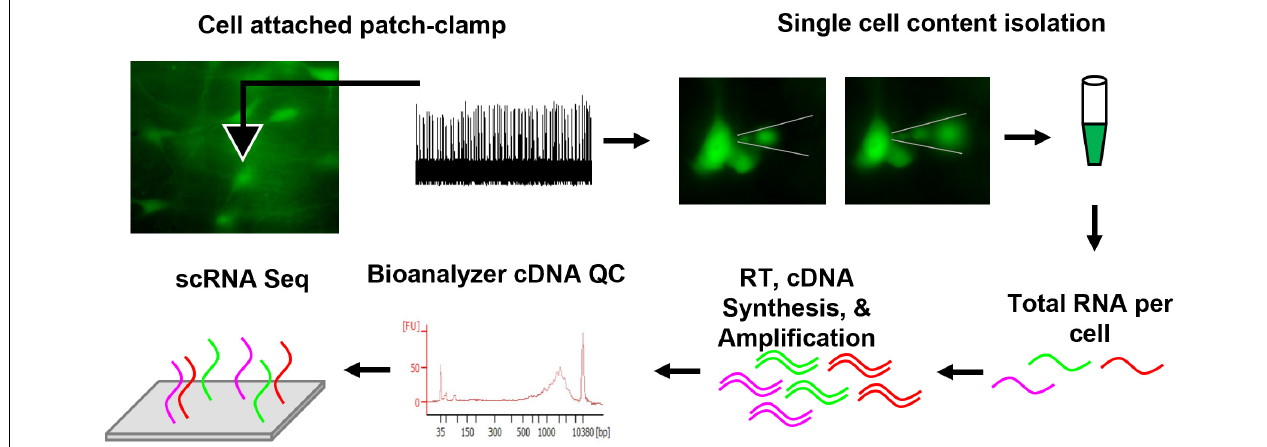
FIGURE 1 | Methodological schematic outlining the patch-seq technique. In summary, eGFP 5-HT neurons were fluorescently identified from an acute brainstem slice, loose cell attached patch-clamp yielded firing rate measurements during control, CO 2 challenge, and washout periods. Thereafter, the recorded neuron’s cell contents were isolated under fluorescence to visualize removal of intracellular content. The content was collected in sterile PBS and frozen. Total RNA per cell was reverse transcribed (RT), cDNA was synthesized, and amplified. Quality control (QC) was completed using an Agilent Bioanalyzer. Samples passing QC were submitted for sequencing. Further methodological details can be found in the section “Materials and